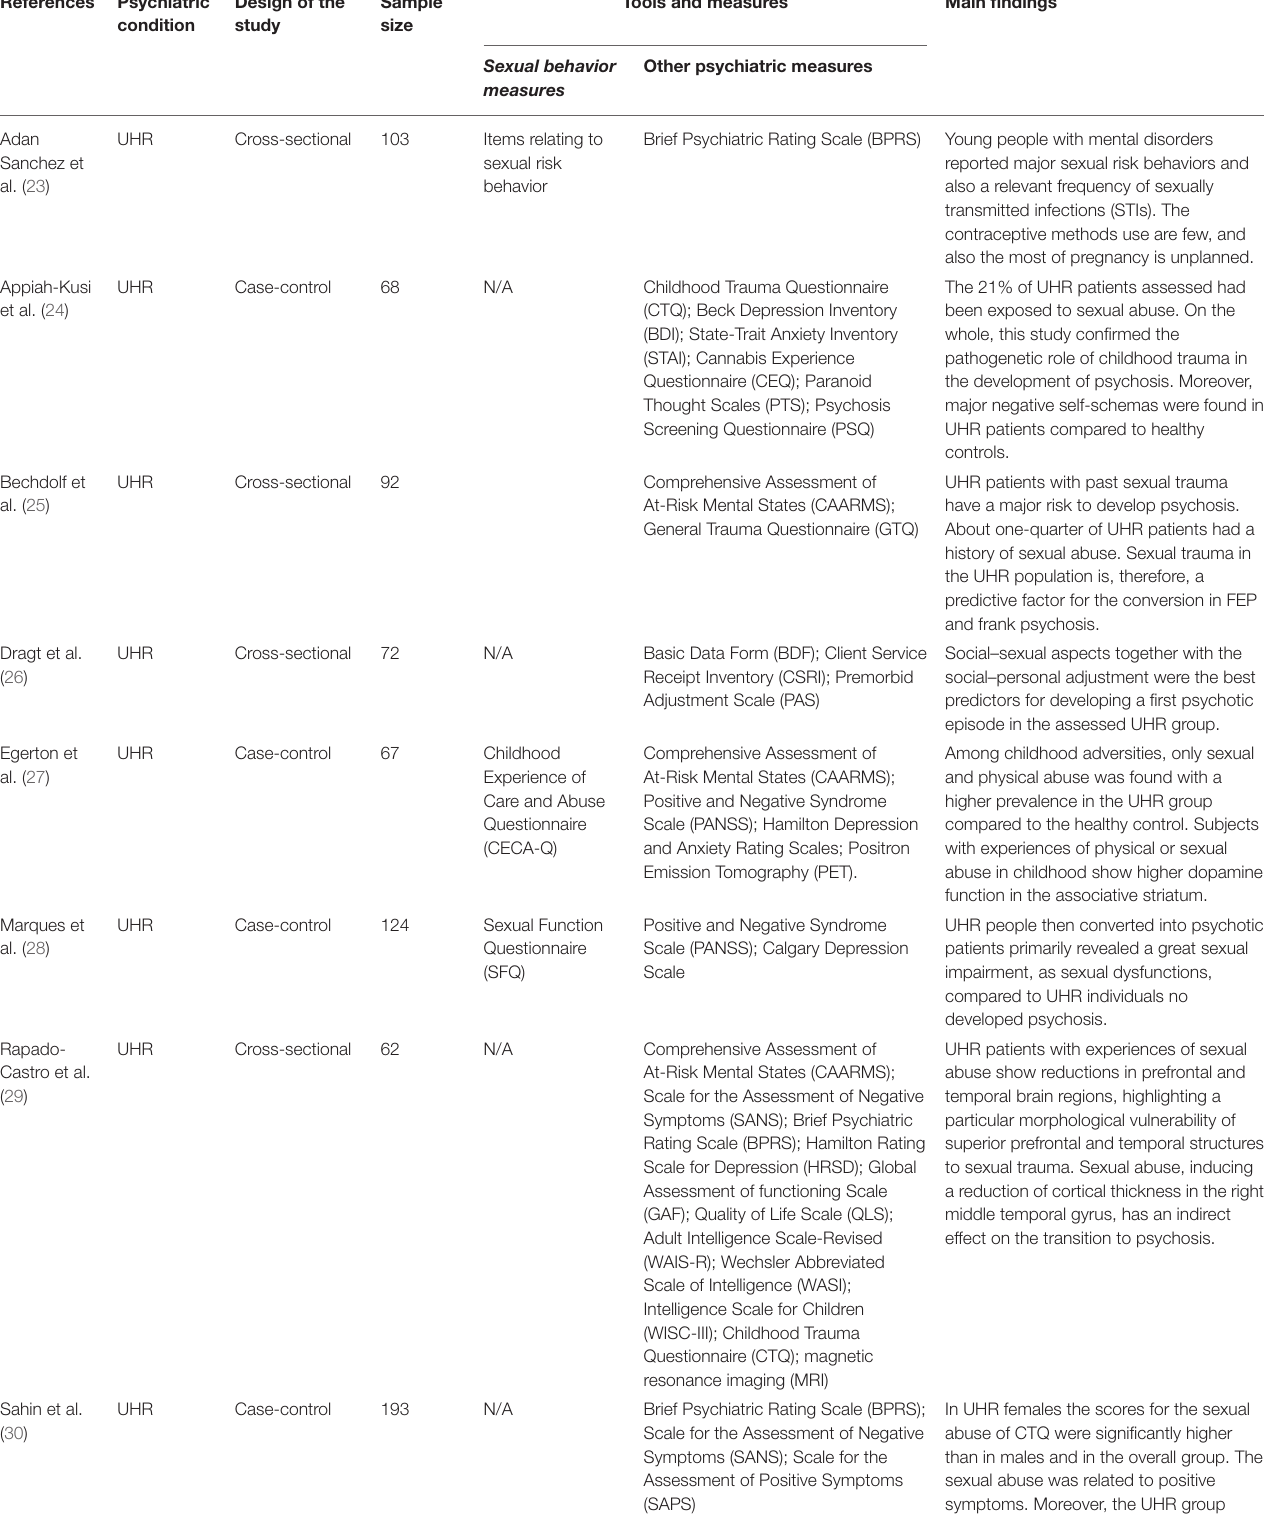
TABLE 1 | Studies inserted in the review analysis about the sexuality in ultra-high risk for psychosis and first-episode